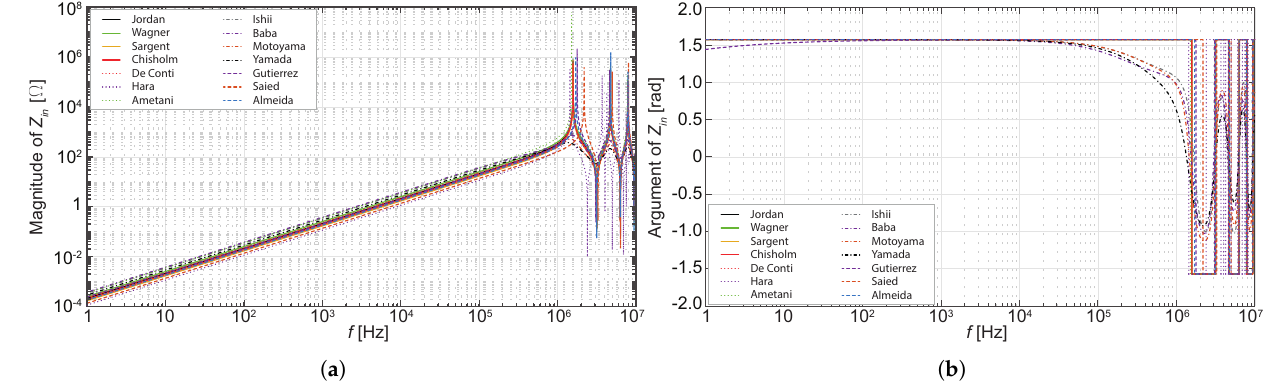
Figure 24. Input impedance Z in ( f ) seen at the top of tower (b) in Figure 16 over a PEC plane. ( a ) Magnitude of Z in ( f ) . ( b ) Argument of Z in ( f ) .